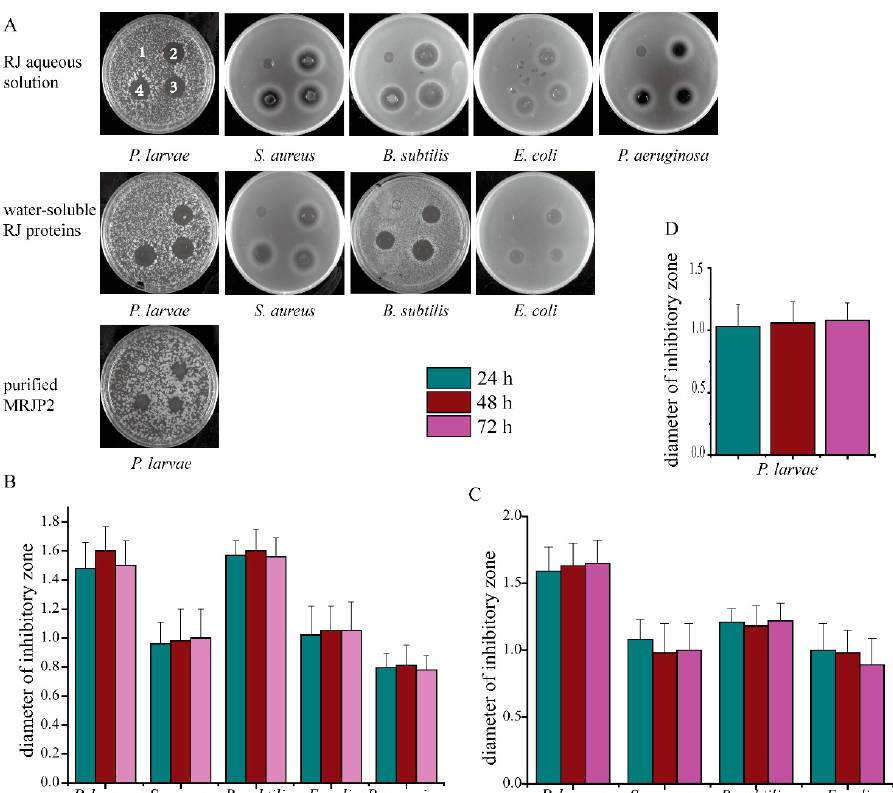
Figure 1. Inhibition plates of royal jelly (RJ) and its derivate components. RJ was collected at 24, 48 and 72 h after the honeybee larvae transferred into the queen cells. ( A ): Inhibition plates of RJ aqueous solution (10%, w / w ), water-soluble RJ fractions, and purified N-glycosyalted major royal jelly protein 2 (N-MRJP2) against Paenibacillus larvae ( P. larvae ), Staphylococcus aureus ( S. aureus ), Bacillus subtilis ( B. subtilis ), Escherichia coli ( E. coli ), and Pseudomonas aeruginosa ( P. aeruginosa ), respectively. “1”, “2”, “3” and “4” represent the blank control, solution from RJ harvested at 24, 48, and 72 h after larvae transfer, respectively. ( B – D ) represent the diameter of inhibitory zones of different bacterial strains treatment with RJ aqueous solution (10%, w / w ), water-soluble RJ fractions (10 µ g/ µ L), and purified N-MRJP2, respectively.